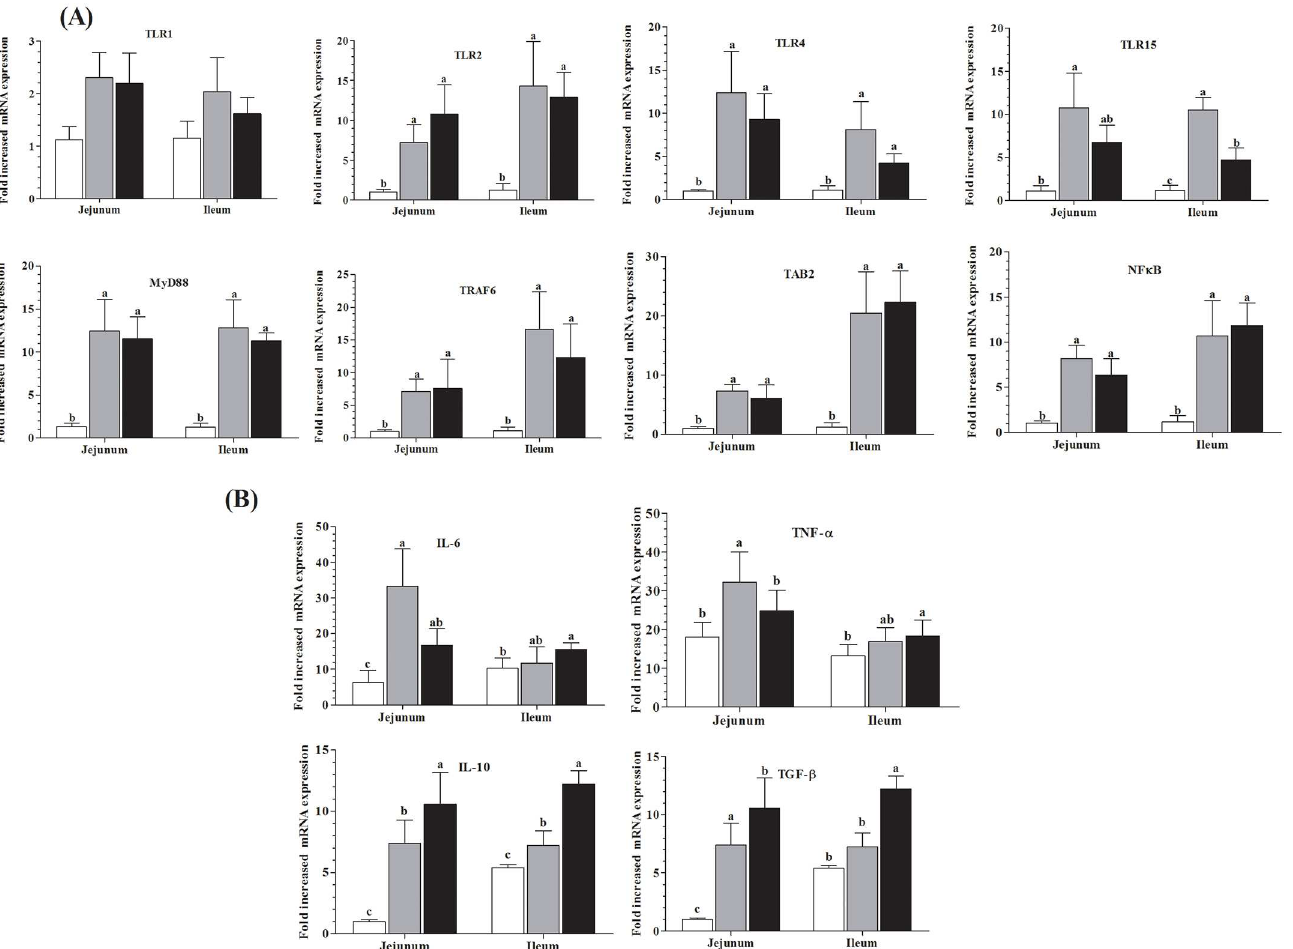
Fig 1. Effects of Sb and Bs B10 on jejunum and ileal mucosal epithelial cells mRNA expression levels. Fig A. After oral administration of Sb and Bs (1x108cfu/g), for seventy-two days mRNA expressions of surface TLR1, TLR2, TLR4, and TLR15 and downstreamassociated factors MyD88, TRAF6, TAB2 and NFkB were evaluated.Fig B. Jejunumand ileal cytokines mRNA expressions of IL-6, TNF- α , IL-10 and TGF- β were determined by qRT-PCR. Data are presented as means of mRNA expressionin fold change ± SD (n = 10). Means with different letters (a, b, c) are definedas significantly different (P <